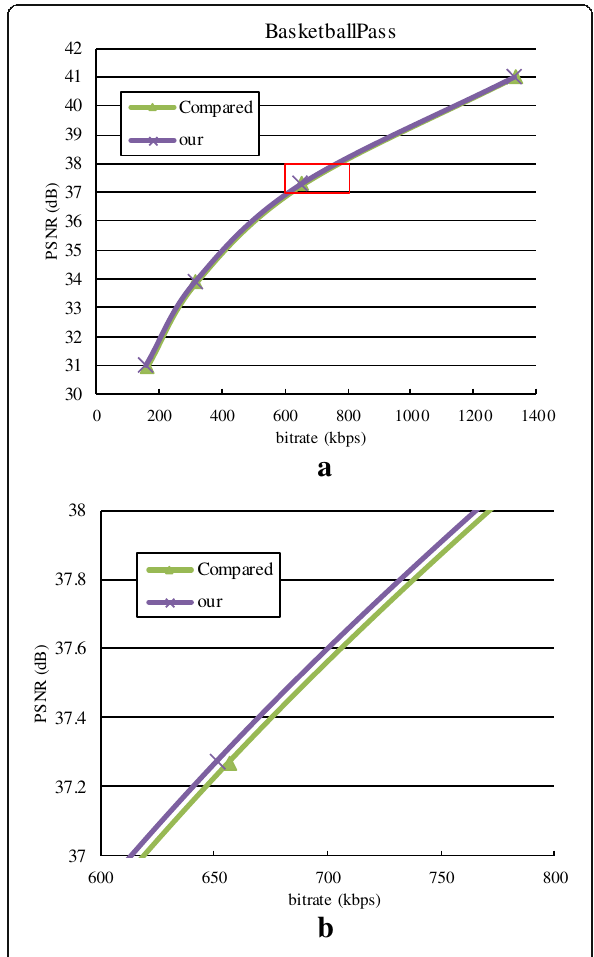
Fig. 9 Comparison of rate distortion performance between the proposed frame level complexity allocation method and the average complexity allocation method for sequence BasketballPass with 90% target complexity proportion. a Rate distortion performance. b Enlargement of red